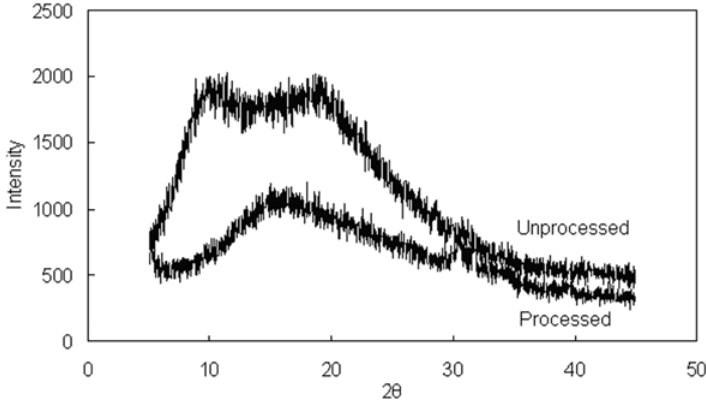
Figure 5. Comparative investigations on XRD patterns of unprocessed and processed